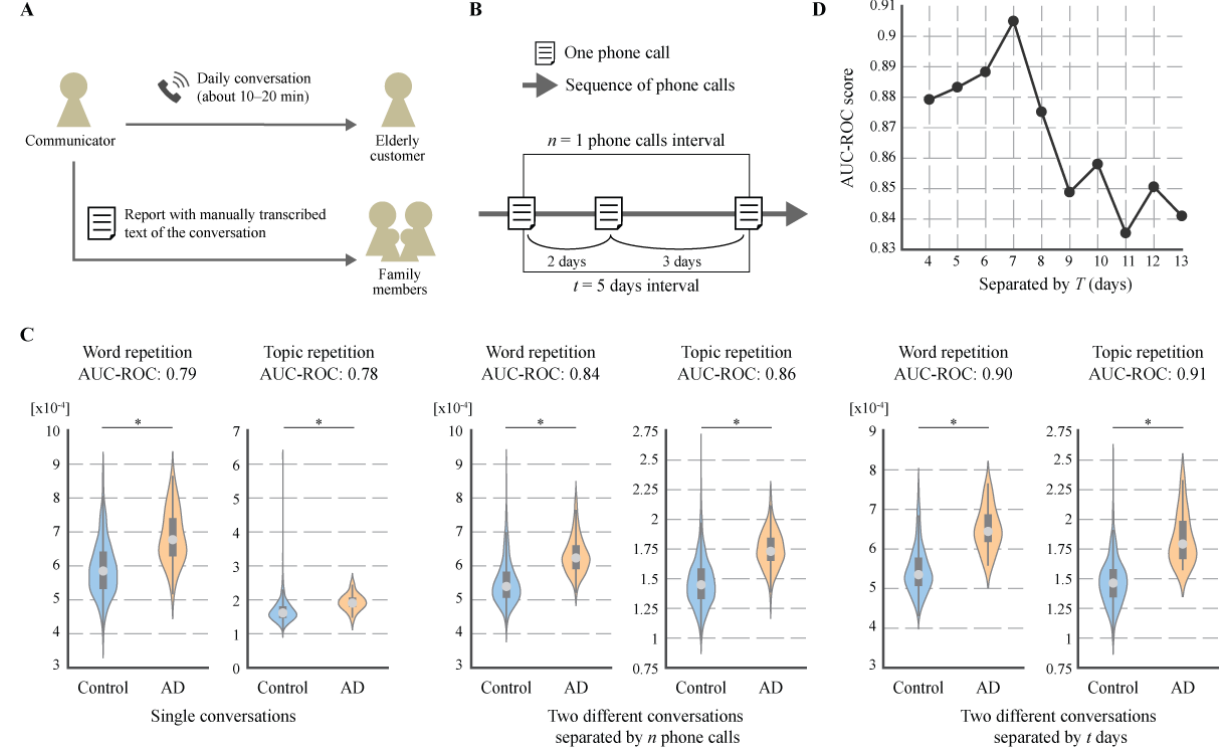
Figure 1. Atypical repetition in conversational data from regular monitoring service. A. Overview of regular monitoring service. The manually transcribed text of the conversation was analyzed in this study. B. Schematic illustrating the paired samples of conversations separated by t days and n phone calls to extract repetition features across different conversations. C. Repetition features of seniors with and without AD. Violin plot is used to visualize the distribution of the data and its probability density. On each side of the violin is a kernel density estimation to show the distribution shape of the data. The wider portion of the violin indicates the higher density and the narrow region represents relatively lower density. The grey box with the whiskers in the violin is the boxplot. The box denotes the 25th (Q1) and 75th (Q3) percentiles. The whiskers denote the upper and lower adjacent values that are the most extreme within Q3+1.5(Q3-Q1) and Q1-1.5(Q3-Q1), respectively. The white dot in the box represents median value. Significant differences are denoted with asterisks (* P <.001). D. AUC-ROC score of topic repetition feature with different T